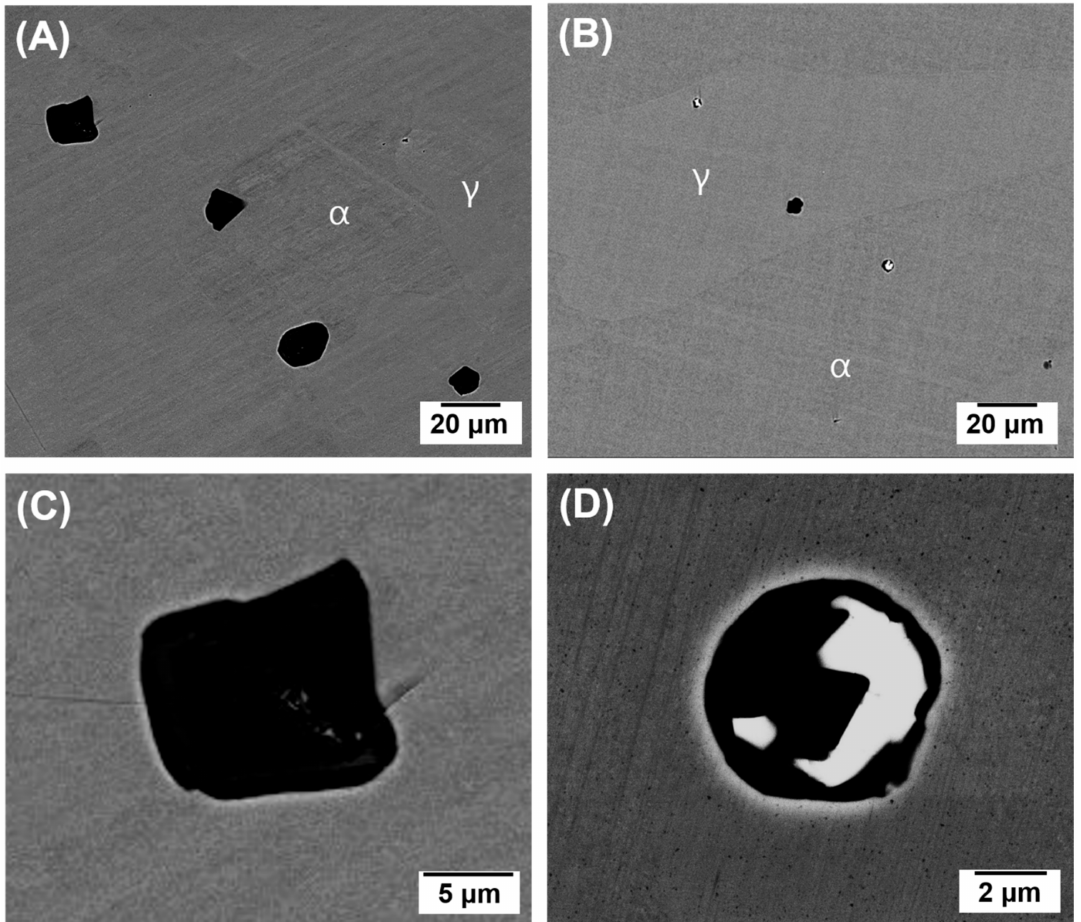
Figure 4. Backscattered electron micrographs of ( A , C ) BDSS and ( B , D ) GDSS. ( A , B ) were taken at low magnification and ( C , D ) at high